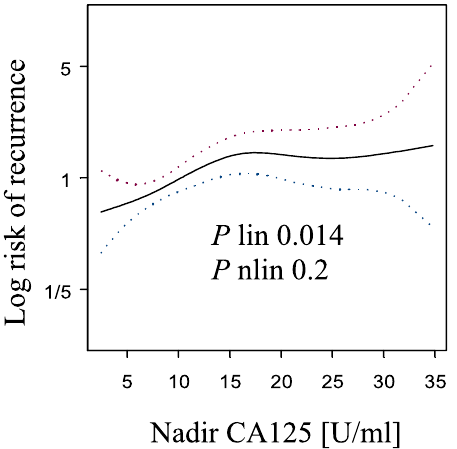
Figure 2. The risk of recurrence and CA-125 nadir level were within the normal range after first-line treatment. A spline indicated that the risk of recurrence initially increased, and at approximately 15 U/ml, it reached a plateau ( p linear = 0.014).